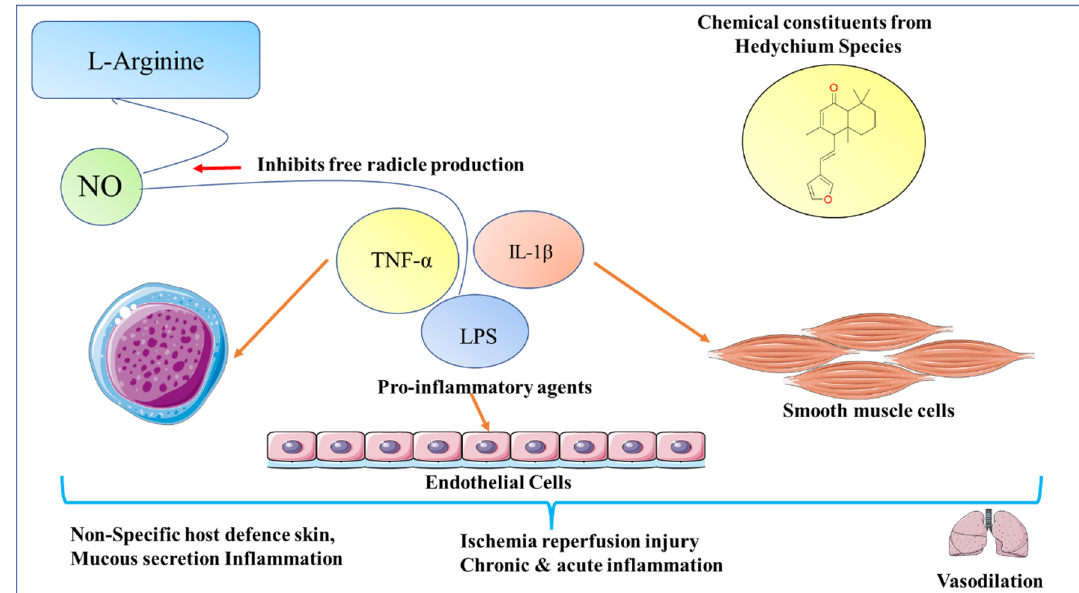
Figure 9. iNOS-induced inflammation by proinflammatory agents in various cells. Inhibition of Acetic Acid-Induced Vascular Permeability in Mice (Anti-Inflammatory) Histamine and serotonin play an important role in the vascular permeability induced by acetic acid, an exudative state of inflammation. The anti-inflammatory effects of methanolic extract of Hedychium coronarium and some labdane diterpenes (Coronarin D, Coronarin D methyl ether) were tested, and the study found that methanol extract (Dose 250–500 mg/kg), Coronarin D (Dose 25–50 mg/kg), and Coronarin D methyl ether (Dose 25–50 mg/kg) had a significance of p < 0.05– p < 0.01 [17]. Inhibition of Released Beta-Hexosaminidase from RBL-2H3 Cells In Vitro (Antiallergic) The 12 compounds of Hedychiol A, Hedychiol B 8,9-diacetate, Hedychilactone A, B, C, Coronarin D, Coronarin D methyl ether, Coronarin E, Labda-8(17), 13(14)-dien-15,16-olide, Hedychenone, 7-hydroxyhedychenone, and (+)-Nerolidol from Hedychium coronarium were examined for an antiallergic reaction by testing their inhibitory effect on the release of beta-Hexosaminidase from RBL-2h3 cells. The study found that the compounds have inhibitory concentrations from 10 µ M to 100 µ M, which were significantly different from the control, with p < 0.05 to p < 0.01 [33]. Coronarin G, Coronarin H, Coronarin I, Coronarin D, Coronarin D methyl ether, Hedyforrestin C, (E)-nerolidol, b-sitosterol, daucosterol, and stigmasterol isolated from Hedychium coronarium were evaluated. The inhibitory effect of the compounds was tested on Lipopolysaccharide-stimulated production of pro-inflammatory cytokines in bone marrow-derived dendritic cells. The compounds Coronarin G, Coronarin H, and Hedyforrestin C were significant inhibitors of LPS-stimulated TNF- α , IL-6, and IL-12 p40 production, with IC 50 ranging from 0.19 ± 0.11 to 10.38 ± 2.34 µ M, and the other compounds are cytotoxic [65]. Figure 10 shows stimulation of TNF- α .